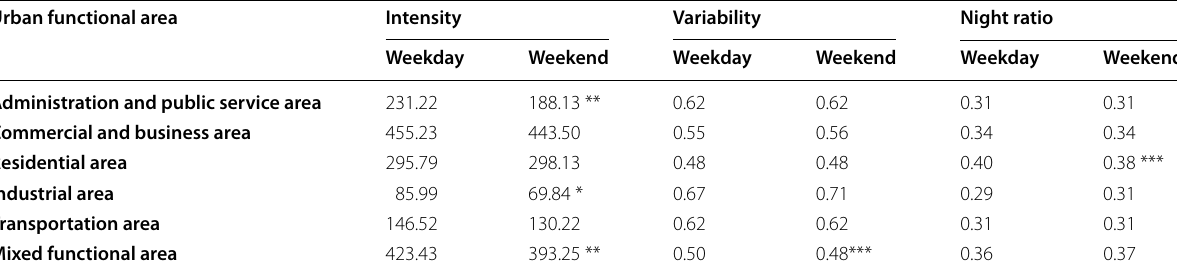
Table 1 Urban vitality indexes among the various urban functional areas